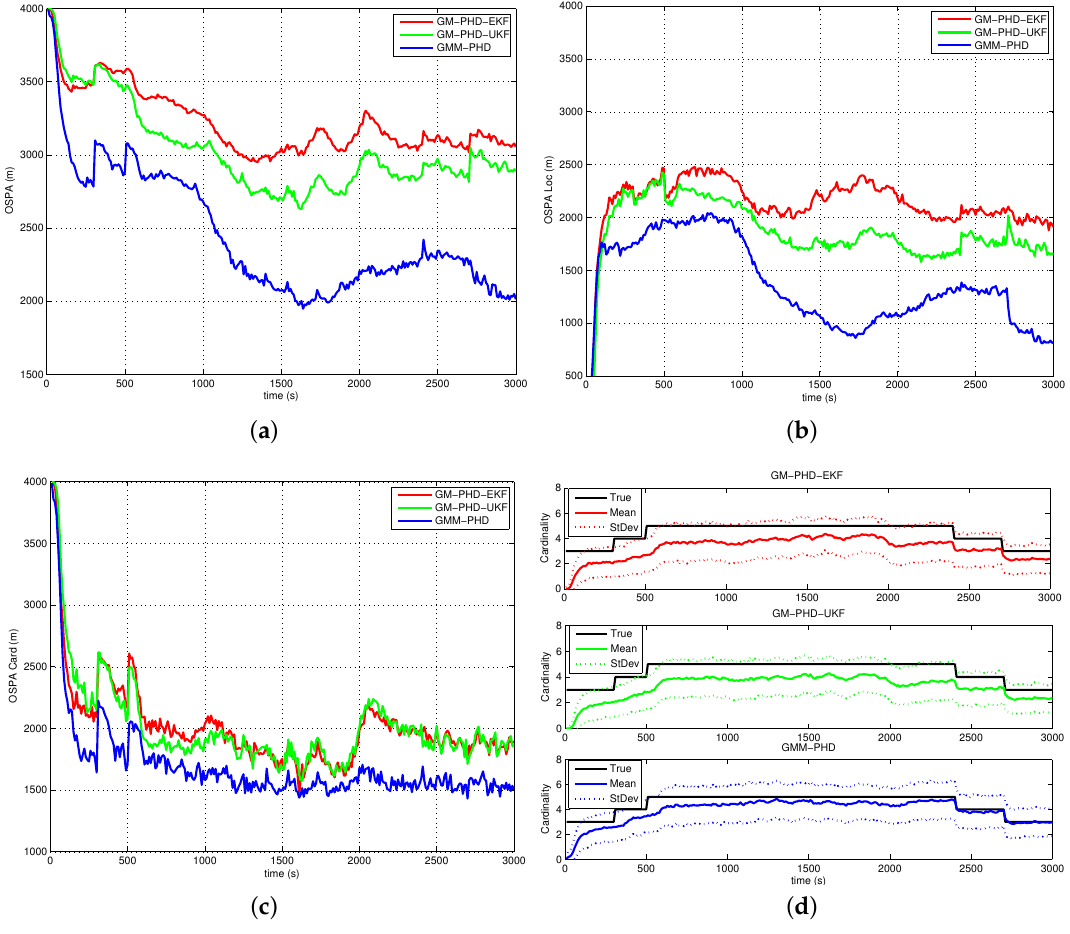
Figure 6. Results of Case 2: ( a ) OSPA distance; ( b ) OSPA localization; ( c ) OSPA cardinality; ( d ) Cardinality